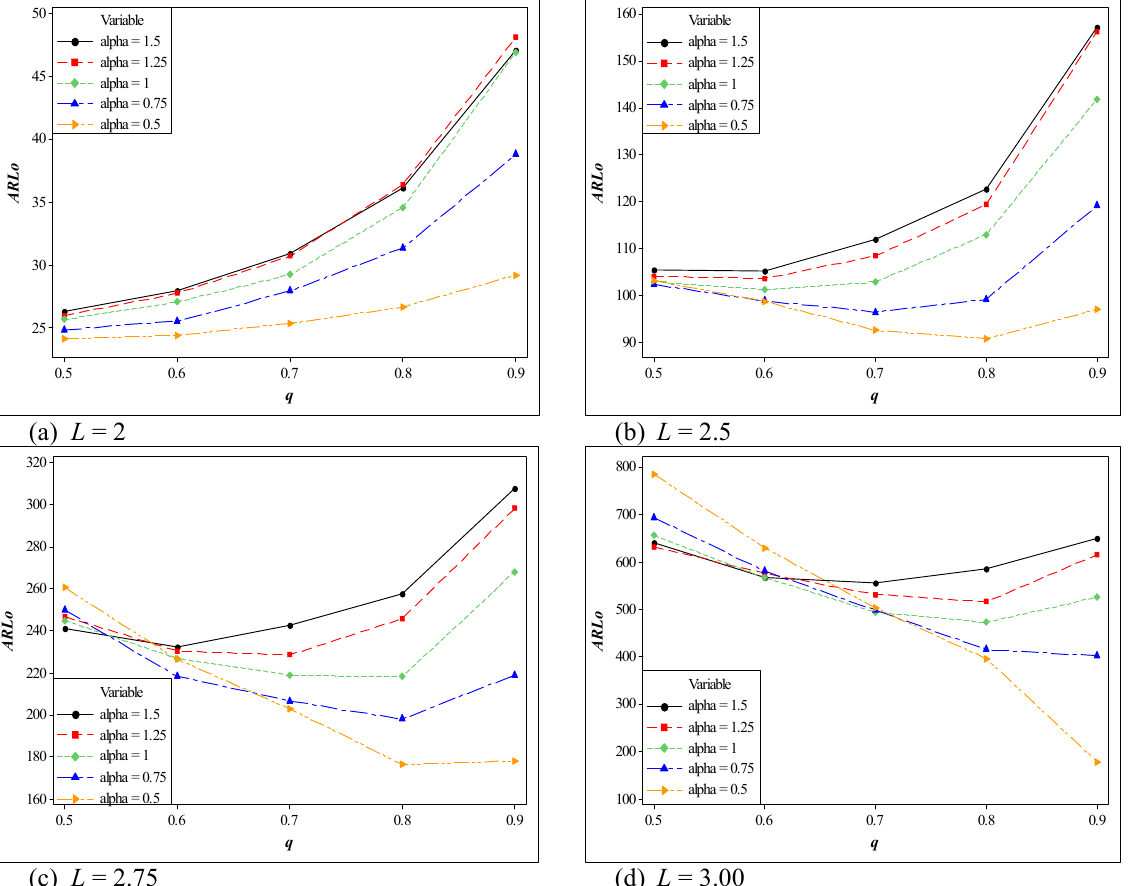
Fig. 2. Attained 𝐴𝑅𝐿 values versus 𝑞 values for different 𝛼 and L values when ( 𝑚, 𝑛 ) = (100, 5) (cid:2868)